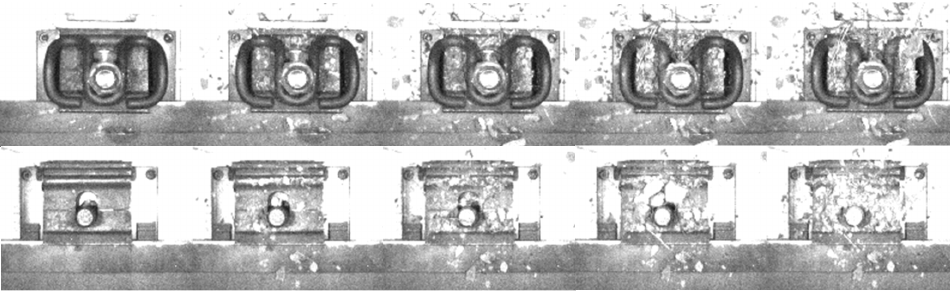
Figure 16. Fastener image with